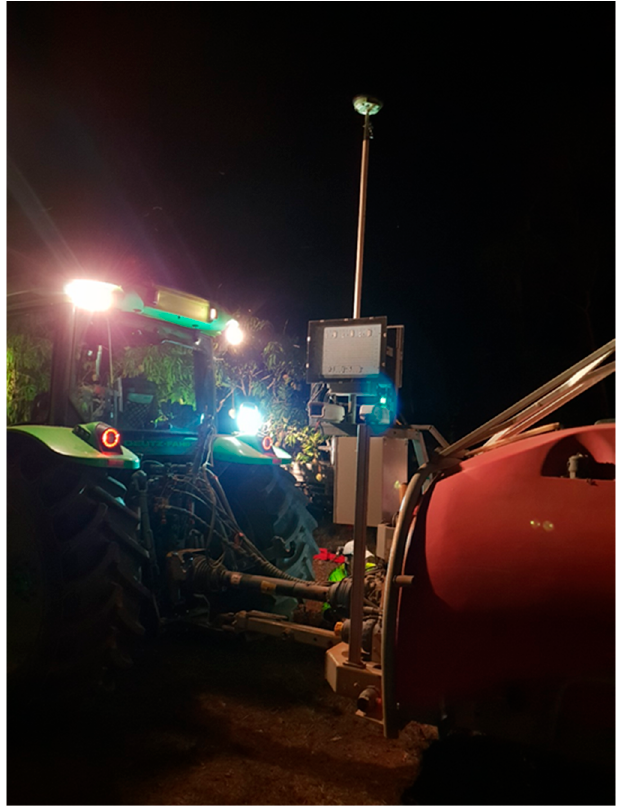
Figure 4. Example of a machine vision system employing LED lighting, GNSS for geolocation and cameras facing in two directions, mounted to a tractor–spray